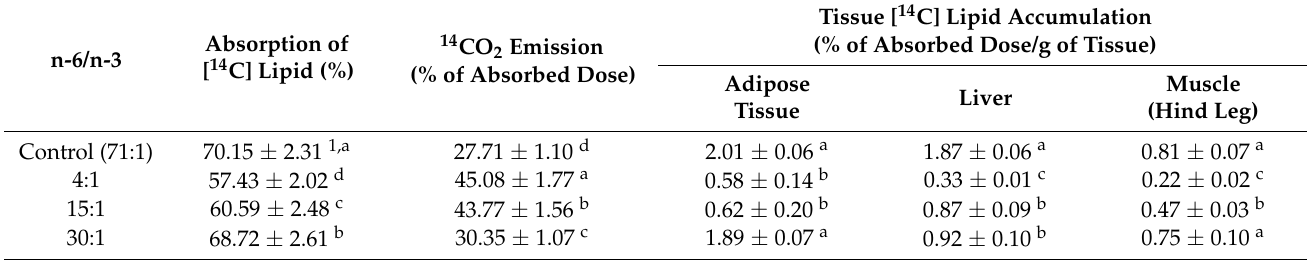
Table 2. Emission of 14 CO 2 and tissue accumulation of [ 14 C] lipid in obese animal biomodel rat-fed diets containing different